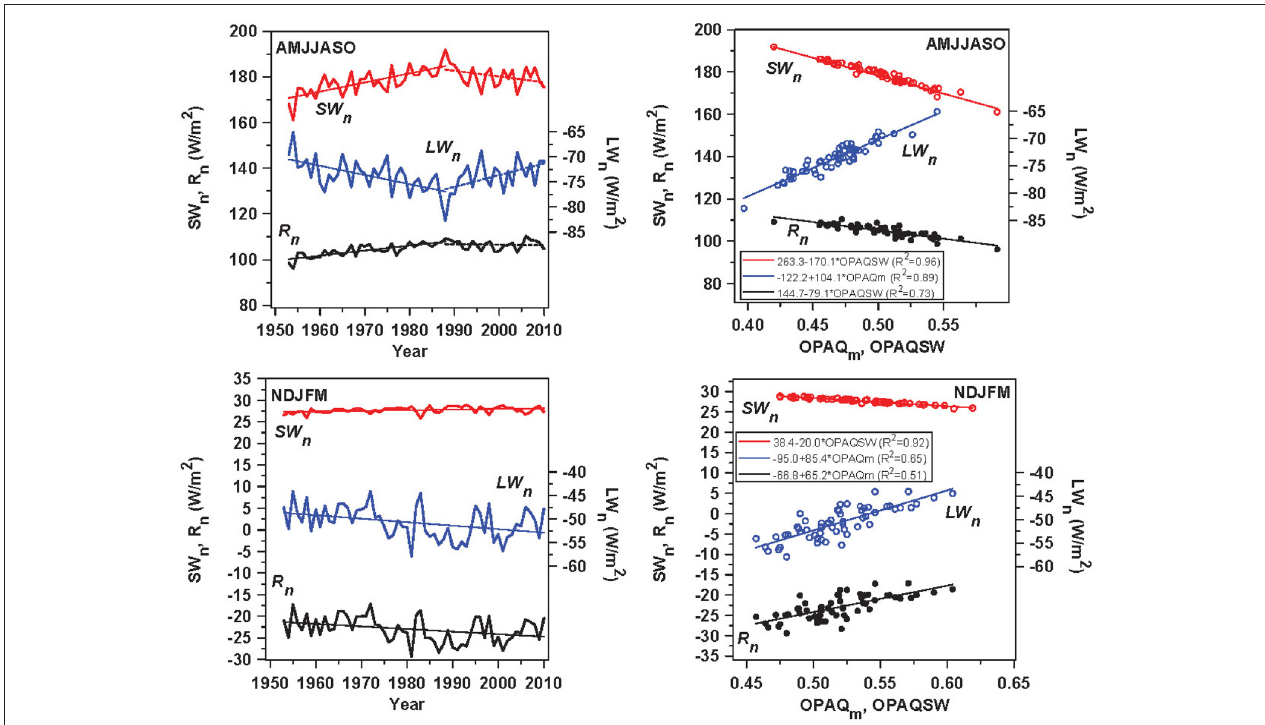
FIGURE 5 | Interannual variability of SW n , LW n , and R n for warm season (AMJJASO) and cold season (NDJFM) (left) and (right) regression of SW n and R n on OPAQSW, LW n on OPAQ m in warm season (top); SW n on OPAQSW, LW n , and R n on OPAQ m in cold season